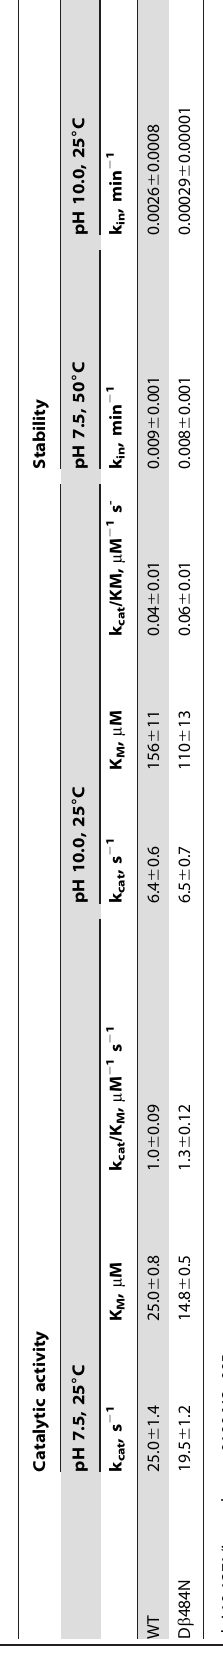
Figure S1 Structural fluctuation (RMSF) of Ec PA and its D b 484N mutant at different pH. Each curve is averaged over three independent MD trajectories. Residue numbers are given in an absolute order. Dashed line separates chains a and b , consisting of 209 and 557 amino acid residues, respectively. Residues b 482 and b 484 are indicated by a red arrow. These positions had one of the lowest RMSF values ( , 0.5 A˚ ) which were the same in the wild type enzyme and its mutant at different conditions. (TIF) Figure S2 Secondary structure as a function of time, for wild type Ec PA at pH 7.5 . The plot is based on a single representative MD, selected from three independent MD runs for the given protein at given conditions. Residue numbers are given in an absolute order. Dashed line separates chains a and b , consisting of 209 and 557 amino acid residues, respectively. Residues b 482 and b 484 are indicated by a red arrow. (TIF) Figure S3 Secondary structure as a function of time, for wild type Ec PA at pH 10.0 . The plot is based on a single representative MD, selected from three independent MD runs for the given protein at given conditions. Residue numbers are given in an absolute order. Dashed line separates chains a and b , consisting of 209 and 557 amino acid residues, respectively. Residues b 482 and b 484 are indicated by a red arrow. (TIF)